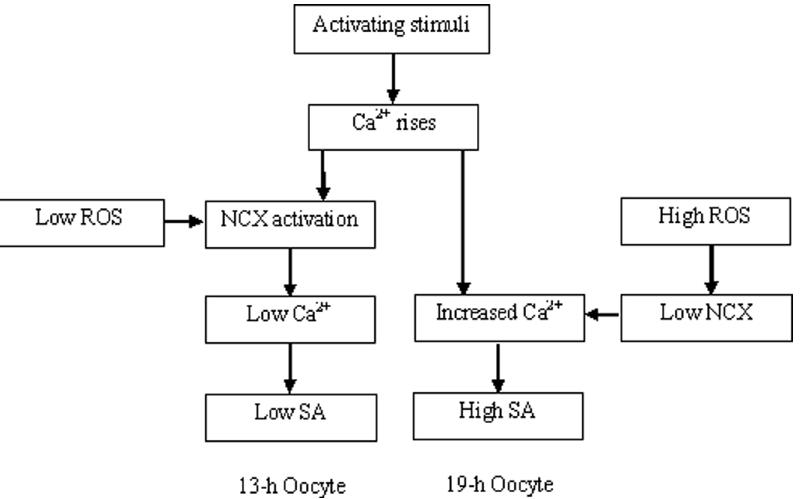
Figure 4. Possible pathways leading spontaneous activation (SA) in freshly ovulated (13 h) and aged (19 h) rat oocytes.